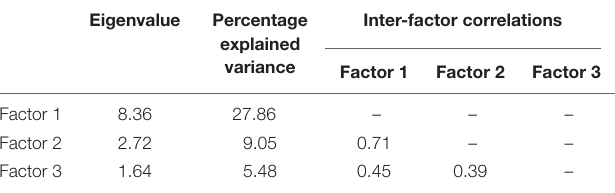
TABLE 4 | Eigenvalues, percentage of explained variance, inter-factor correlations and factor-total correlations for the ARS-30. Eigenvalue